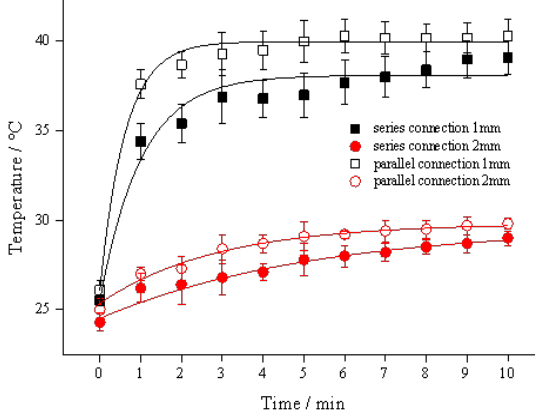
Figure 3. Temperature profile of apple juice fulfilled in sample coils with different connections at 800 V, 400 Hz, d 2 = 8 mm. Note: two connections were displayed with N S = 2 ×